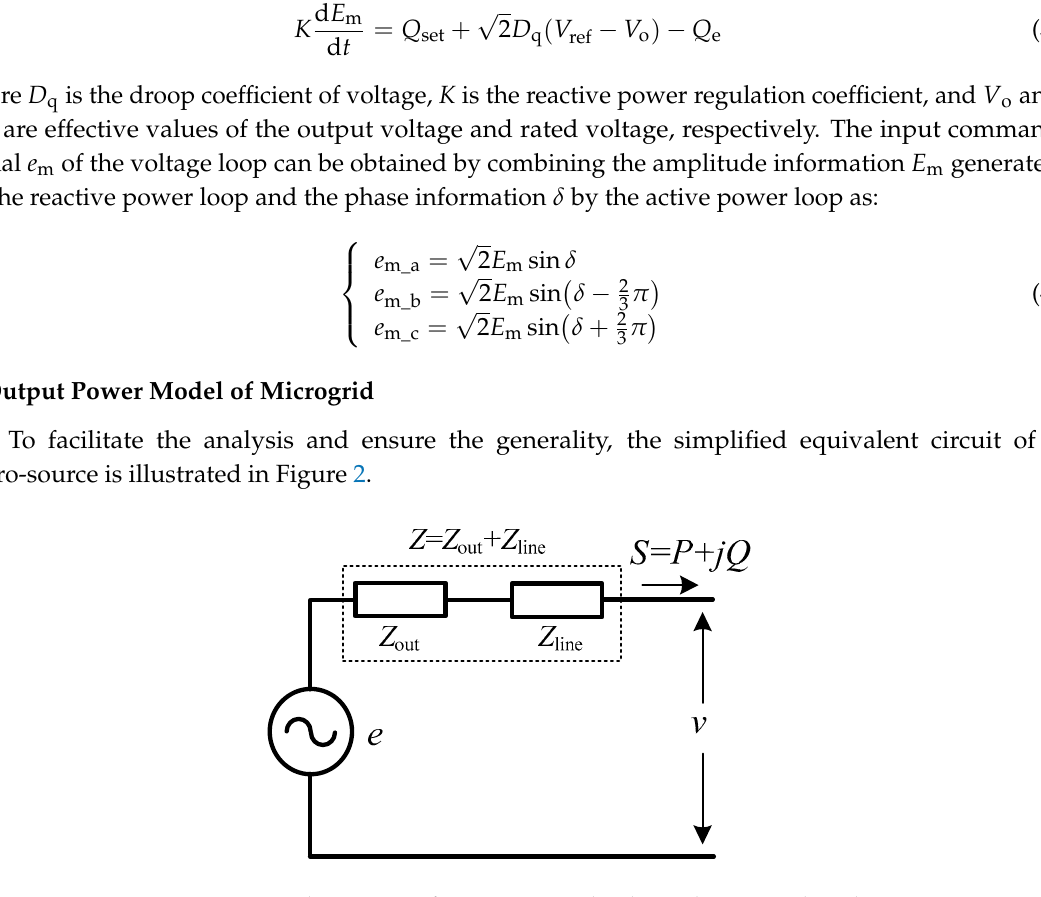
Figure 2. Equivalent circuit of an inverter under the grid-connected mode.